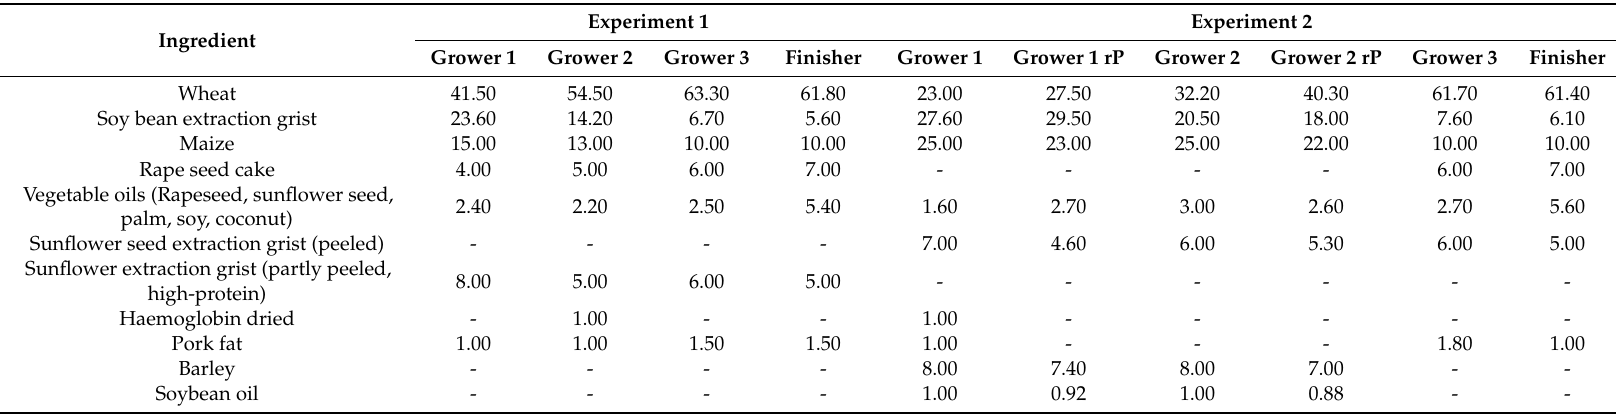
Table 2. Formulae (%) provided by the feed company of the standard and protein-reduced (rP) grower and finisher feeds used in Experiments 1 and 2 for fattening the turkey